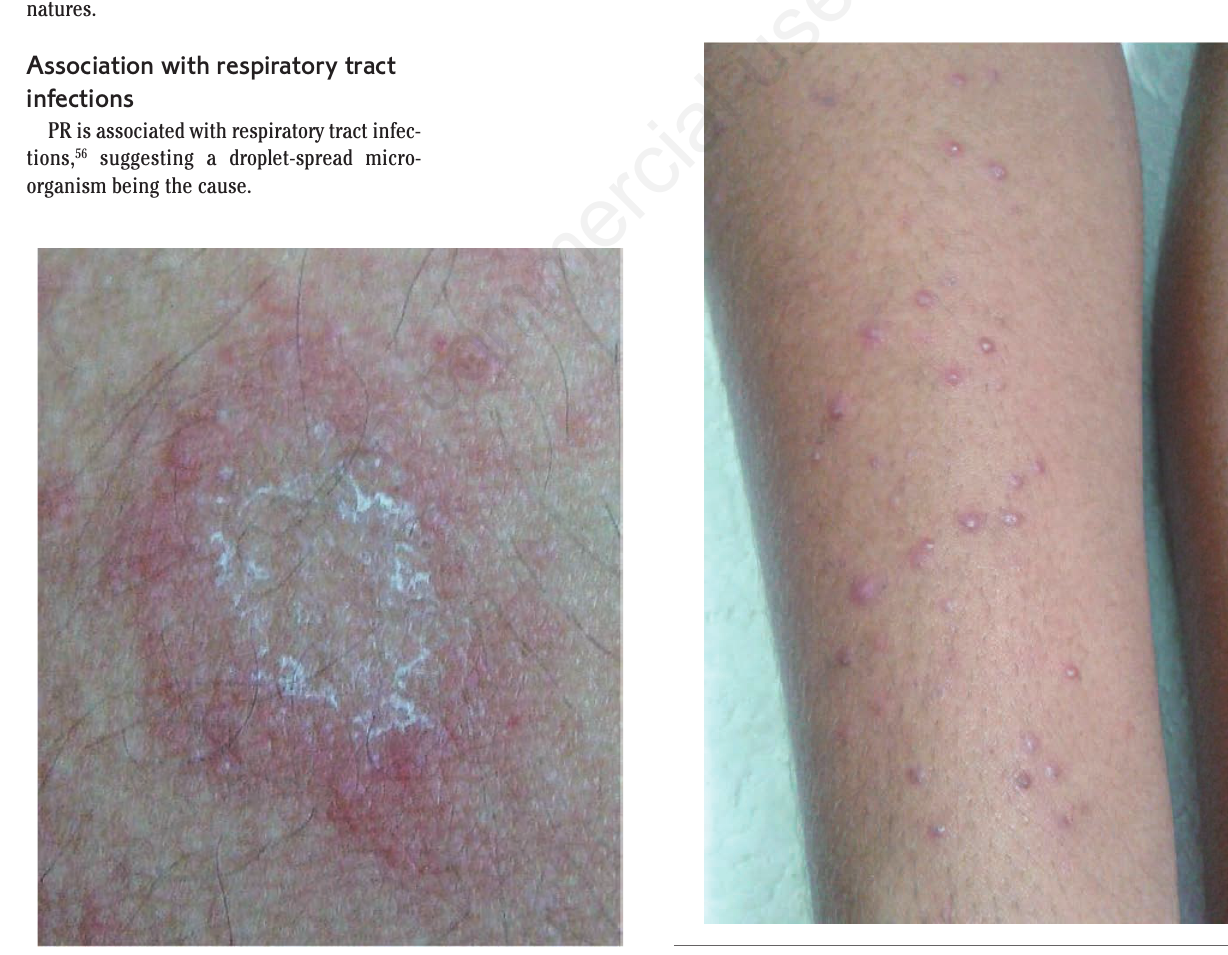
Figure 1. A herald patch demonstrating peripheral collarette scaling in a patient with pityriasis rosea